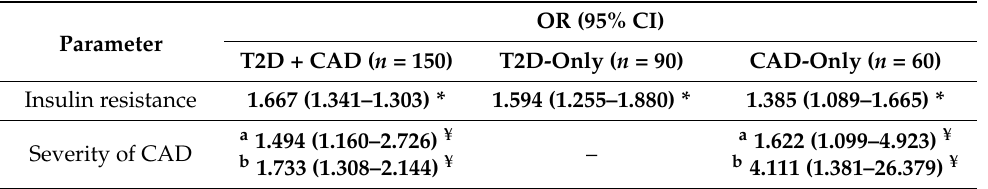
Table 4. Association of RBP-4 levels with IR and the severity of CAD.